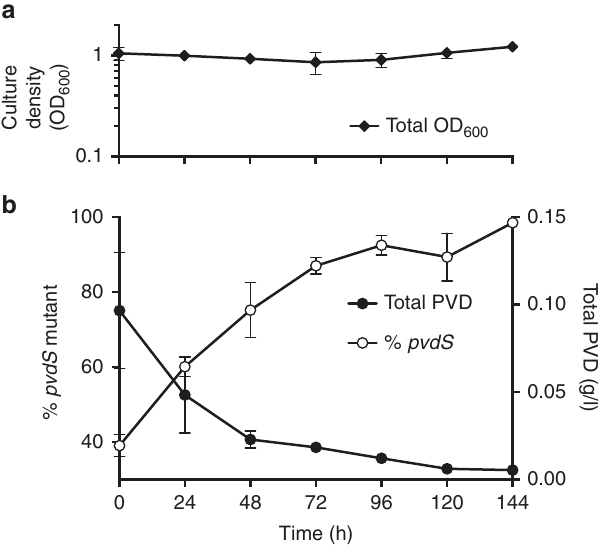
Fig. 4 Change in population density, frequency and PVD concentration during C-limited chemostat culture. a Total population density. b Proportion of the pvdS mutant in WT co-culture, and total concentration of PVD in the chemostat over time. Co-cultures of WT and pvdS mutant were initiated in C-MEM at the indicated ratio. Error bars indicate SEM, n =